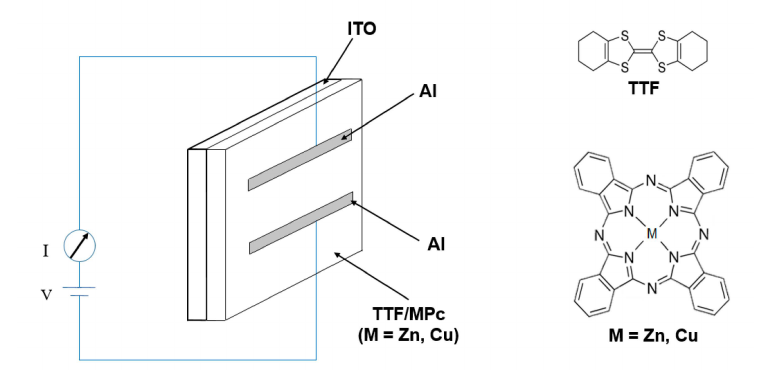
Figure 5. Chemical structures of MPc and TTF derivative and Schematic structure of